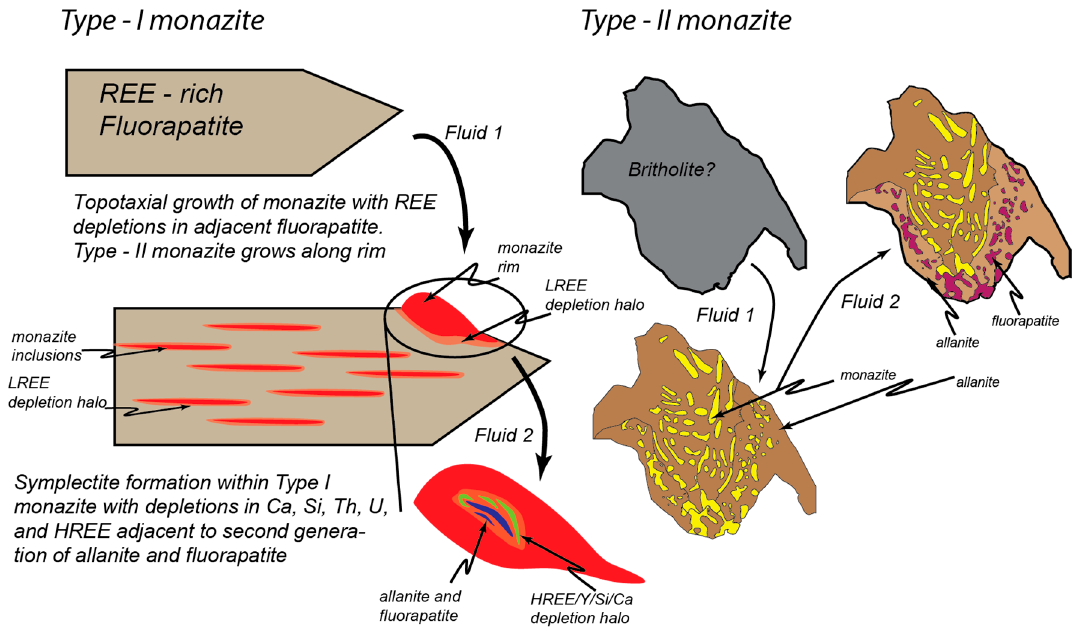
Figure 6. Schematic drawing proposing the reaction history and textural evolution of monazite- allanite-fluorapatite assemblages discussed in this study.